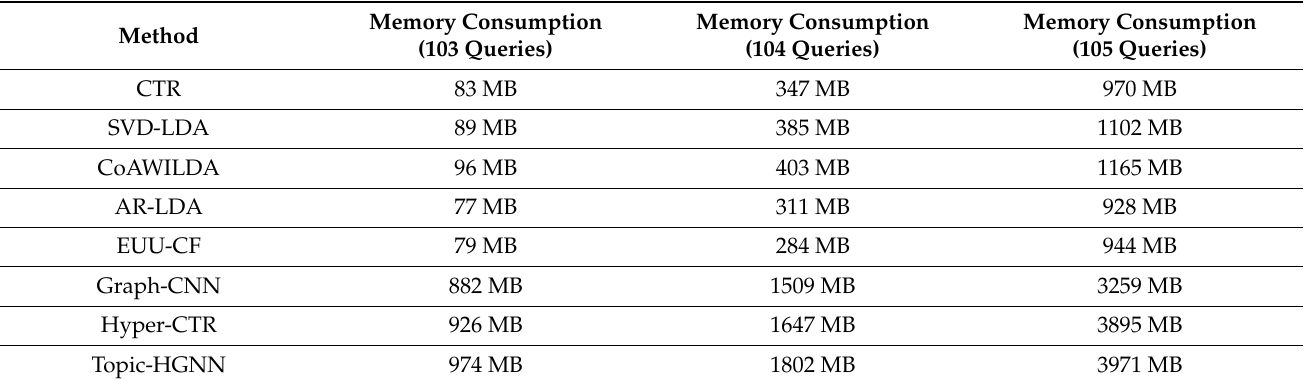
Table 4. The memory consumption of each method under different query search volumes on Retail- rock dataset (the number of recommendation results is